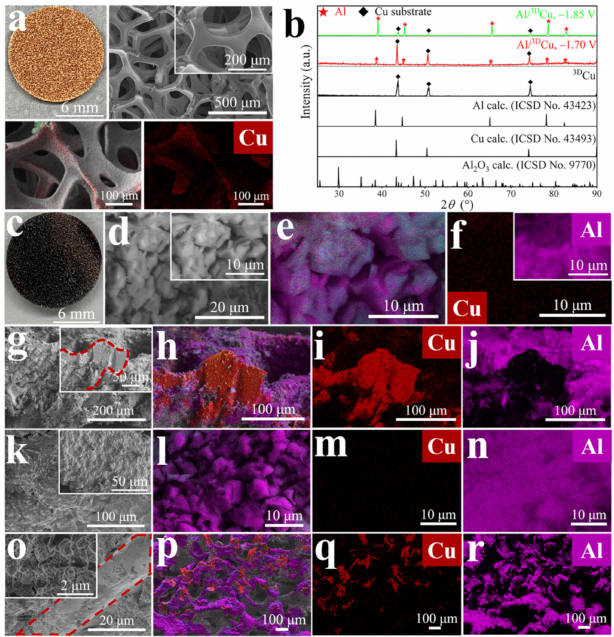
Figure 3. ( a ) Photograph, SEM images (enlarged details as inset) and EDX mappings of all elements of the Cu distribution of the pristine 3D Cu substrate. ( b ) PXRD patterns comparison. ( c ) Photograph of Al/ 3D Cu electrode electrodeposited at –1.70 V and 90 ◦ C. Surface ( d – f , k – n ) and cross-sectional ( g – j , o – r ) SEM images (enlarged details as inset and skeleton structure of 3D Cu indicated with red dotted lines) and EDX mappings of all elements of the Cu and Al distribution of the Al